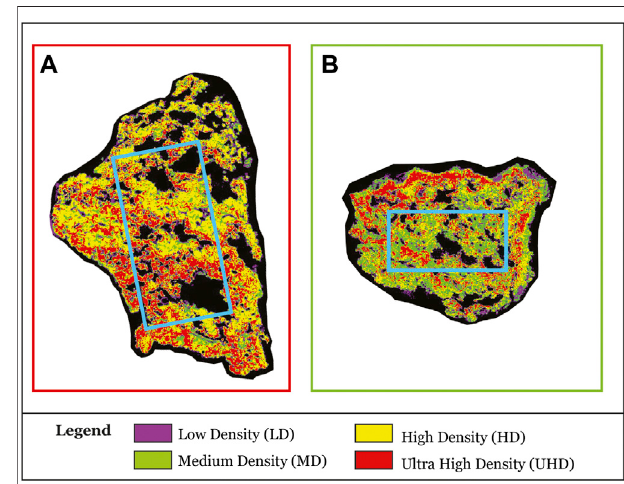
FIGURE 5 | Example of one slice per sample after the CT fragmentation via thresholding. (A) CBR2_3_7c fragmentation. (B) CBR2_4_21c f fragmentation. Light-blue lines indicate the sections of the cylindrical sub- volumes considered for the calculation.